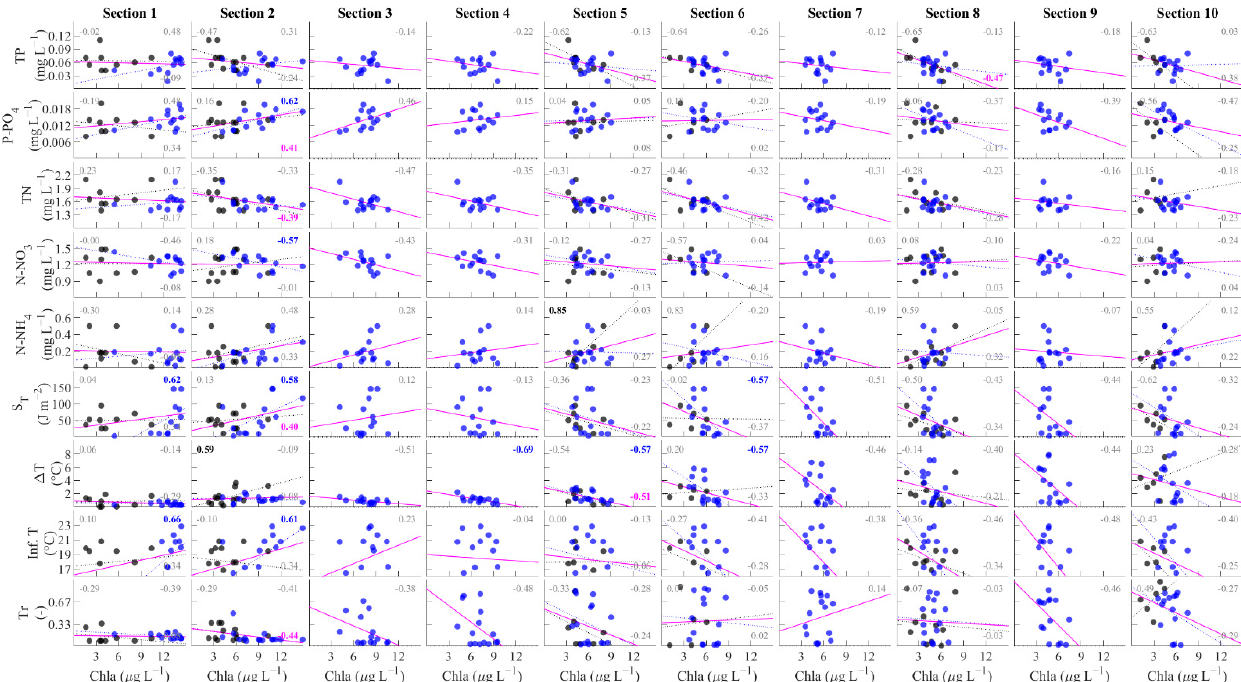
Figure 10. Correlations of chla obtained from samples (black dots) and remote sensing images (blue dots) with: measured inflow concentration of TP, P-PO 4 , TN, N-NO 3 , N-NH 4 , Schmidt stability (S T ), the mean temperature difference between surface and bottom water ( Δ T), measured inflow temperature (Inf. T), and tracer ratio (Tr). The columns represent data for 10 longitudinal sections, and rows represent the different parameters. All panels present the Pearson correlation coefficient for sampling ( top left ), remote sensing ( top right ), and both combined ( bottom right ) chla estimates. Numbers in gray indicate that the correlation was not significant ( p > 0.05).